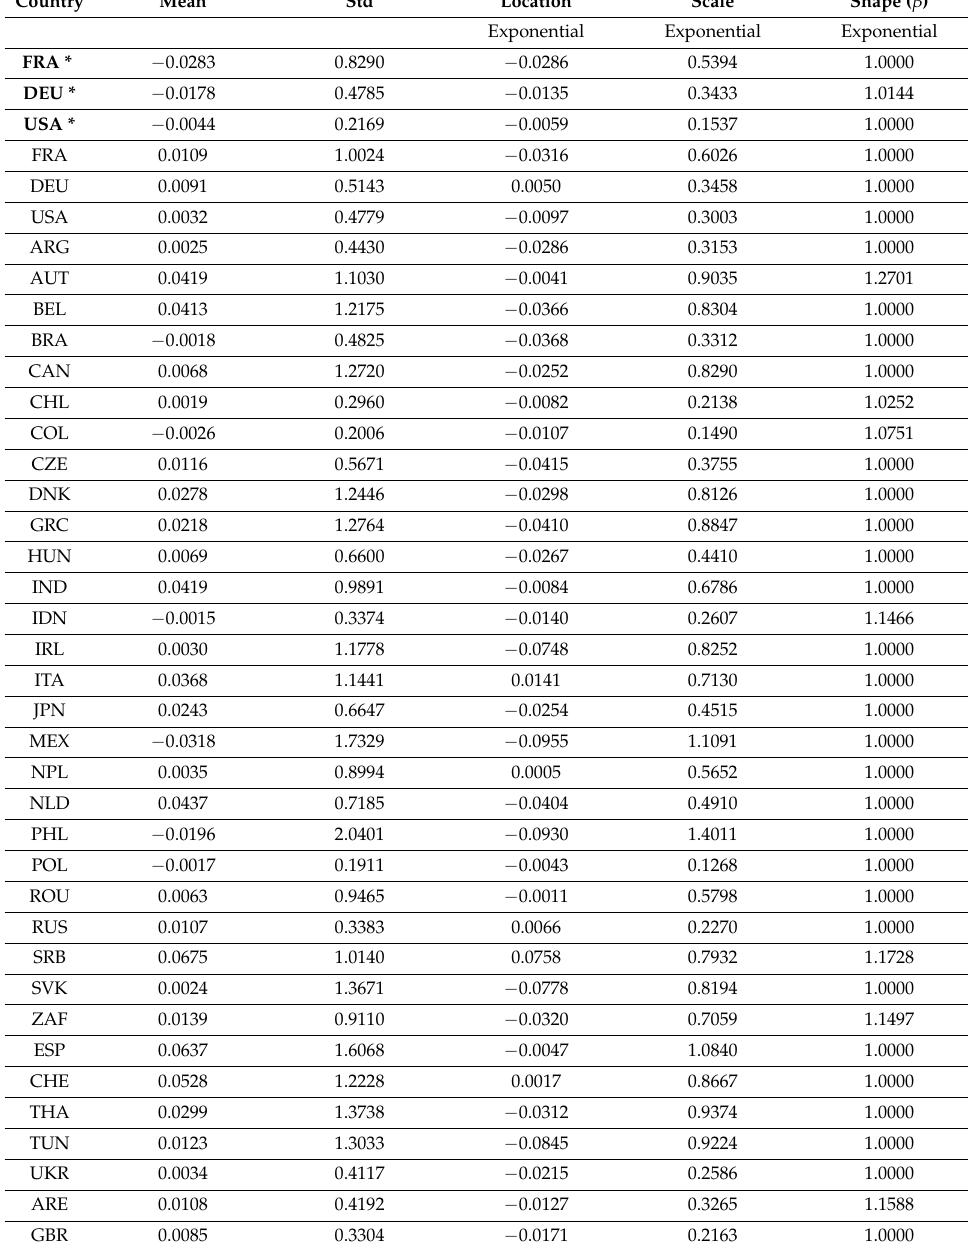
Table A1. Table with the mean and standard deviation of ε t and the parameters of the best fit to the exponential distributions for 36 countries. The data of starred countries in the first three rows have undergone the festive bias